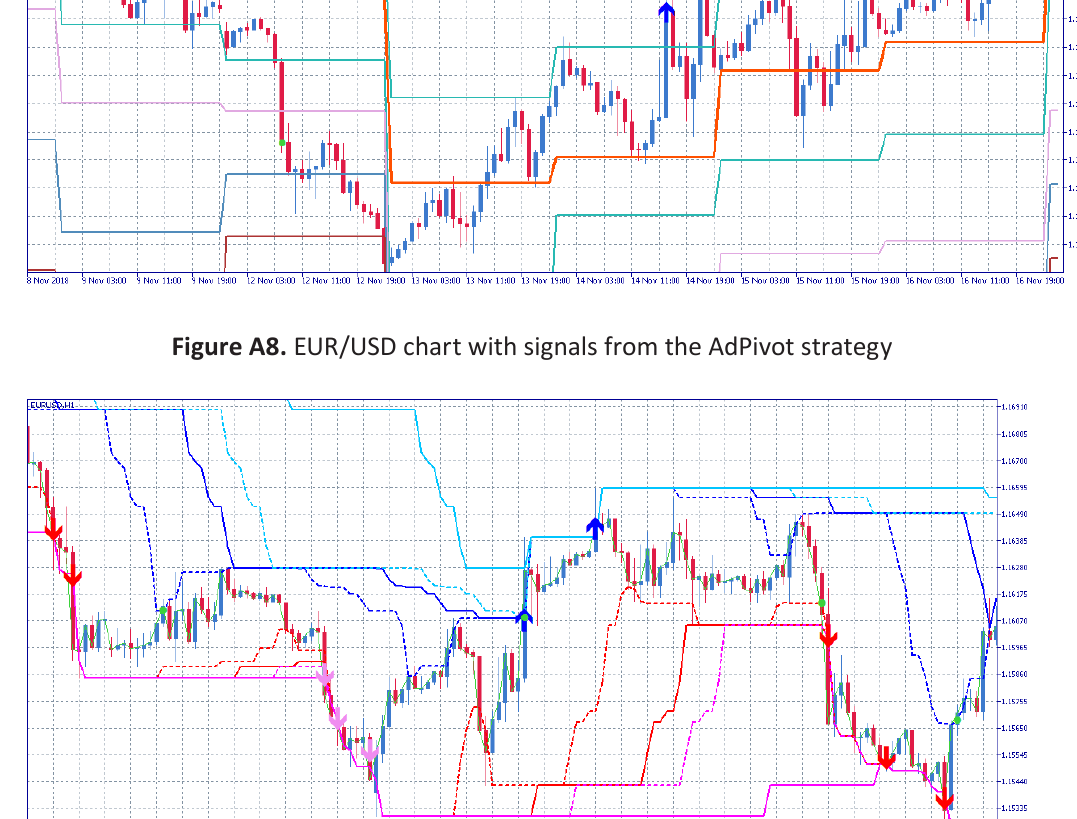
Figure A9. EUR/USD chart with signals from the AdTurtle